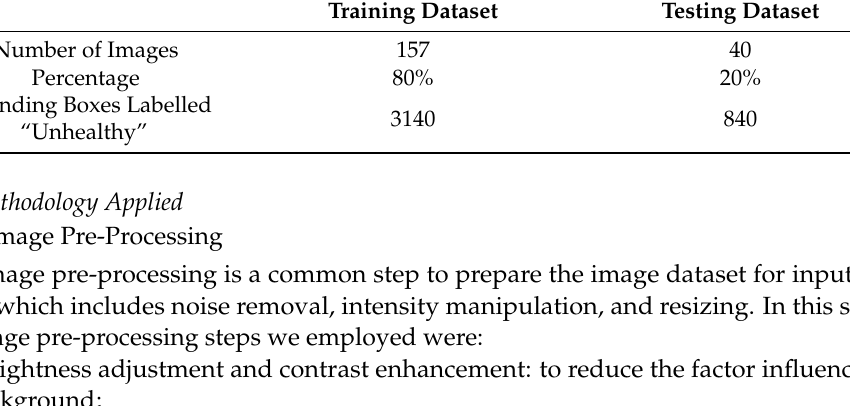
Table 1. Number of images and bounding boxes in the training and testing datasets.